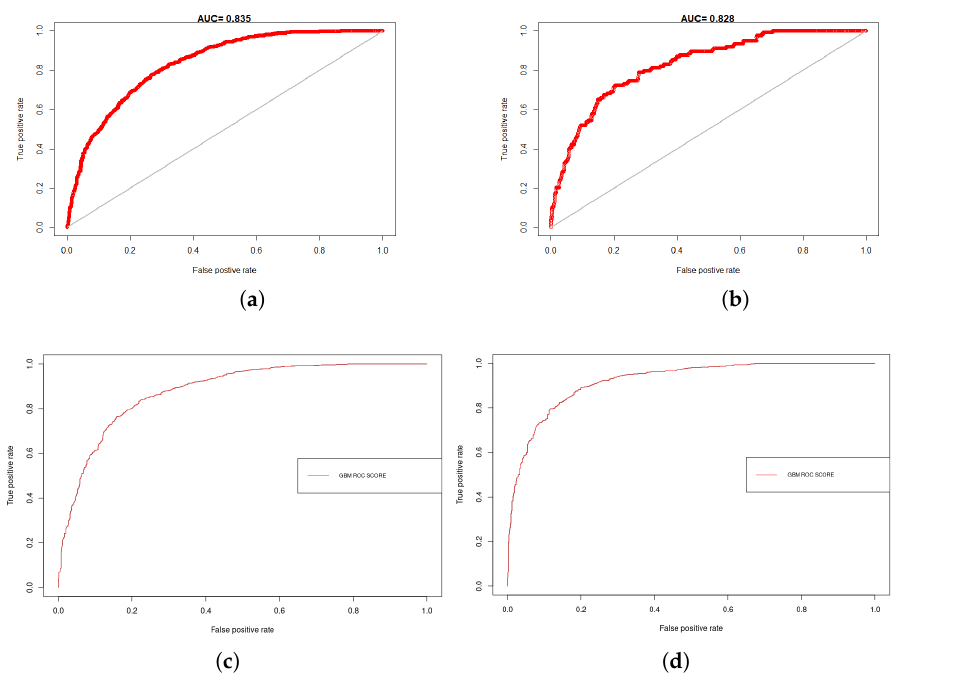
Figure A3. ROC curves for BTD and IBR from ME and BRT at different thresholds. ( a , b ) The ROC curves for BTD and IBR, respectively, from ME. ( c , d ) The ROC curves for BTD and IBR, respectively, from BRT.